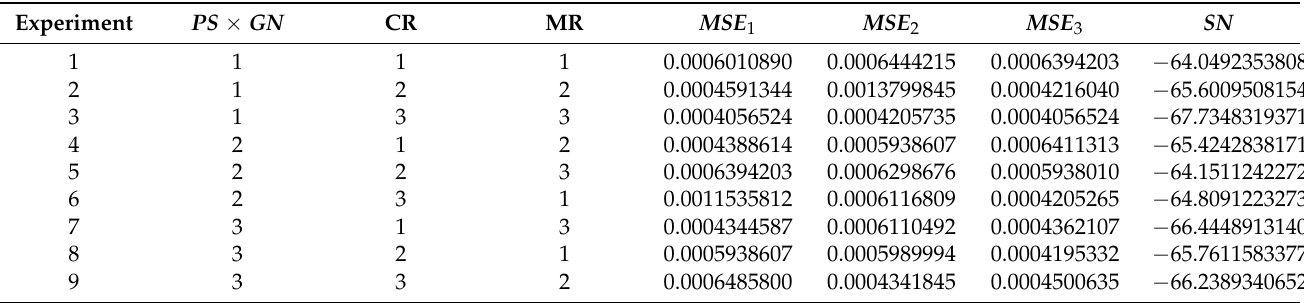
Table 3. The L 9 ( 3 3 ) orthogonal array for system.